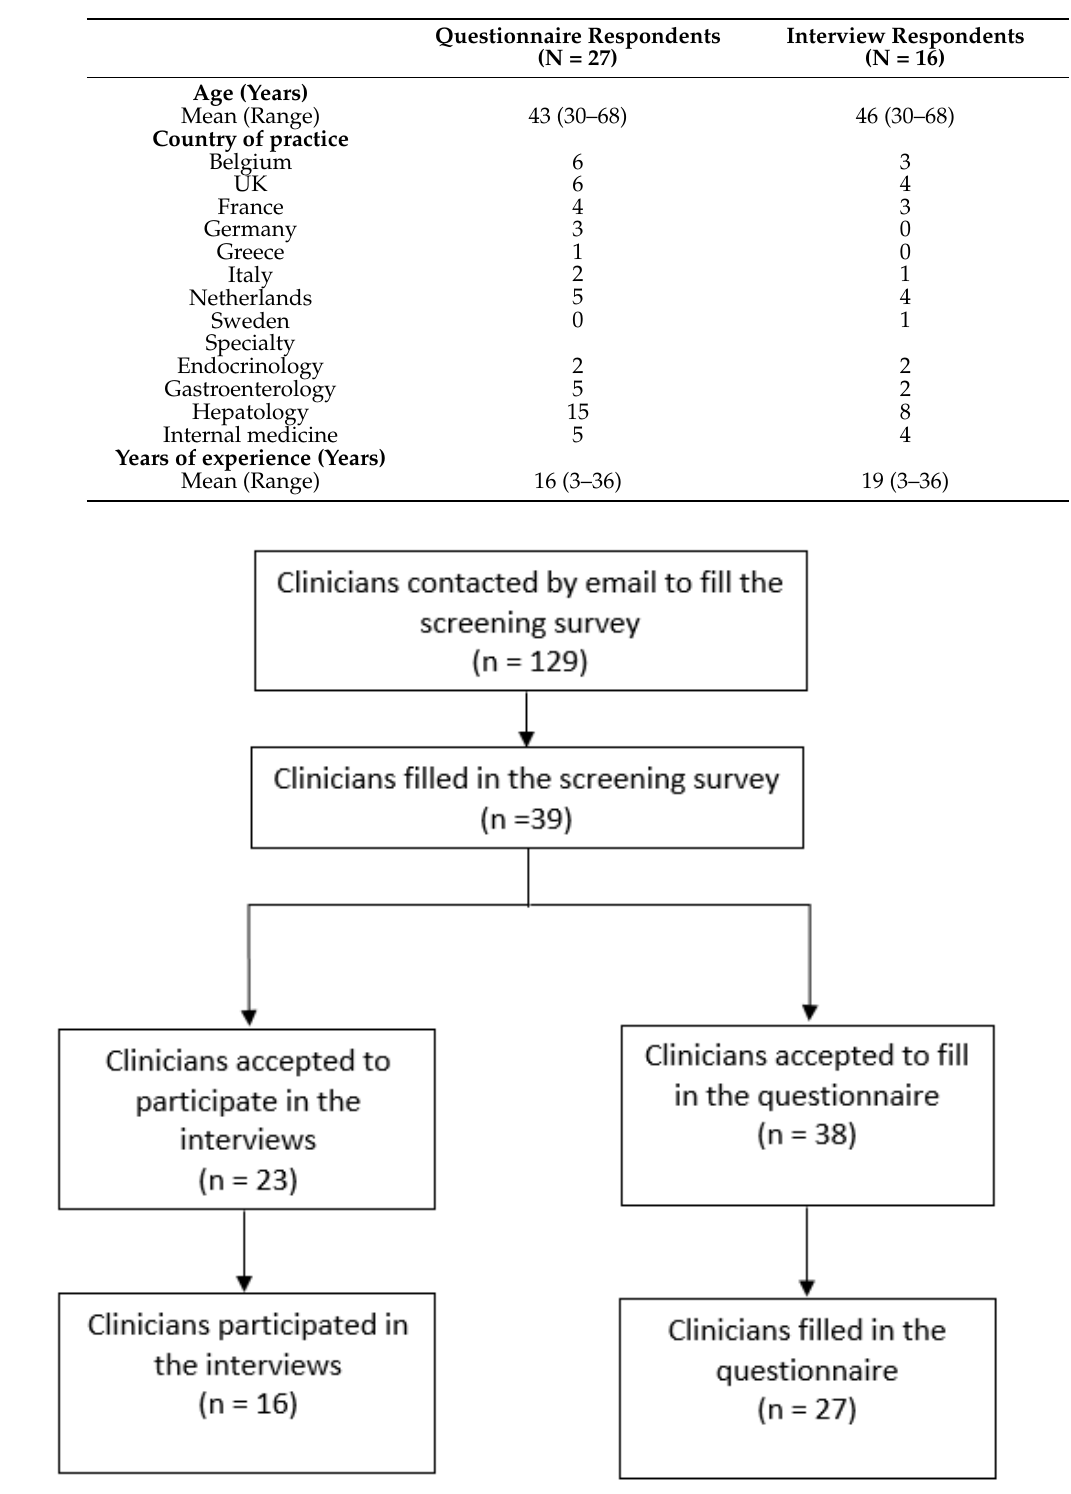
Table 1. Baseline characteristics of questionnaire respondents and interview respondents.